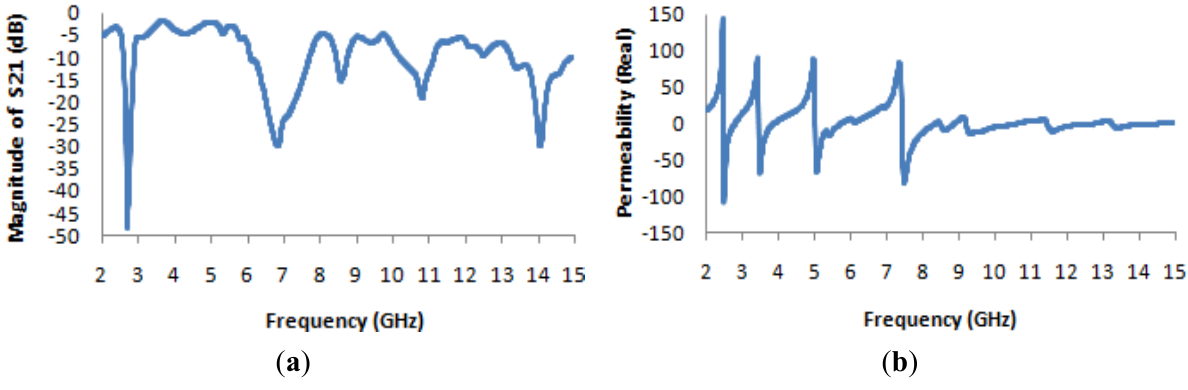
Figure 16. ( a ) The magnitude of the transmission parameter (S 2 × 2 unit cell; ( b ) the real value of permeability vs. the frequency for the 2 × 2 unit cell.